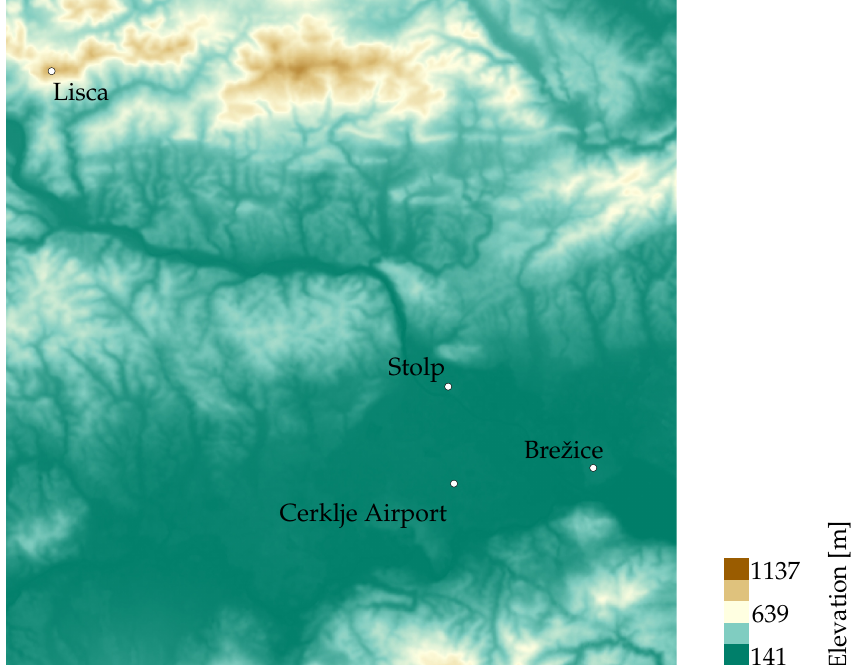
Figure 3. Digital elevation model [32] of the study area (30 km by 30 km) with the meteorological stations marked.